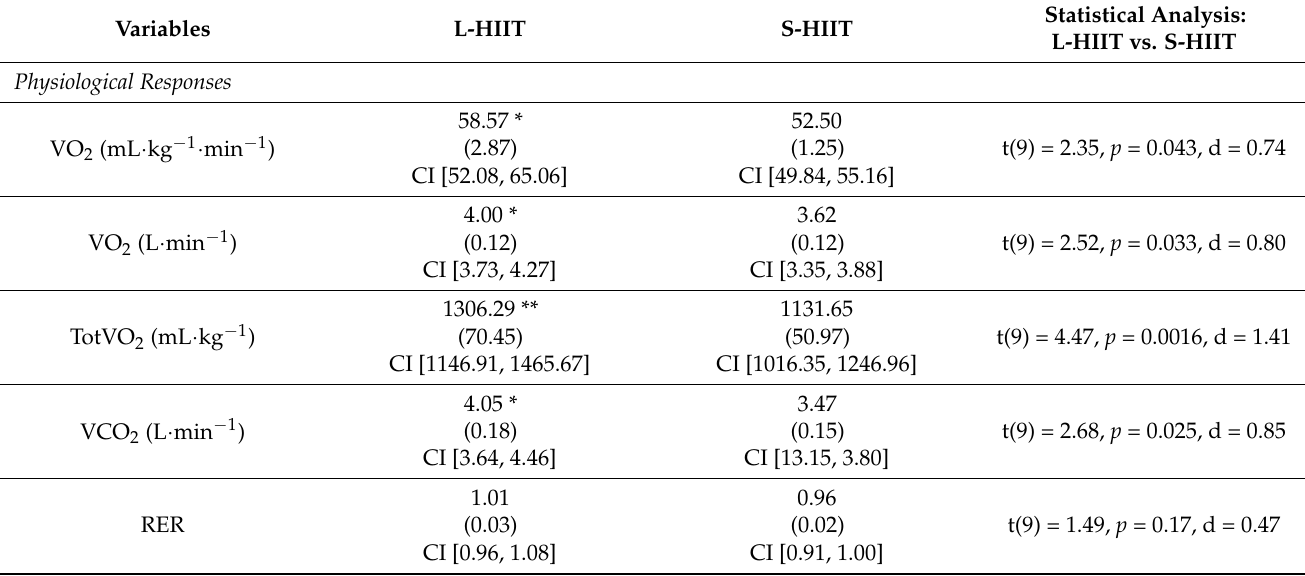
Table 3. The physiological responses, performance parameters and internal workload after long HIIT (L-HIIT) and short HIIT (S-HIIT). The normally distributed data are provided as the mean ± SE; not normally distributed data values are presented as the median (interquartile range). VO 2 , oxygen uptake; TotVO 2 , total oxygen uptake consumed; VCO 2 , volume of carbon dioxide exhaled; RER, respiratory exchange ratio; VE, ventilation; T@90% VO 2 max, time spent per session in exercise bouts at an intensity close to or above 90% of maximal oxygen uptake; TD, total distance; PPO, peak power output; RPE, rate of perceived exertion; HRmax, maximum heart rate; [La] + , blood lactate concentration, CI, confidence interval; d, Cohen’s